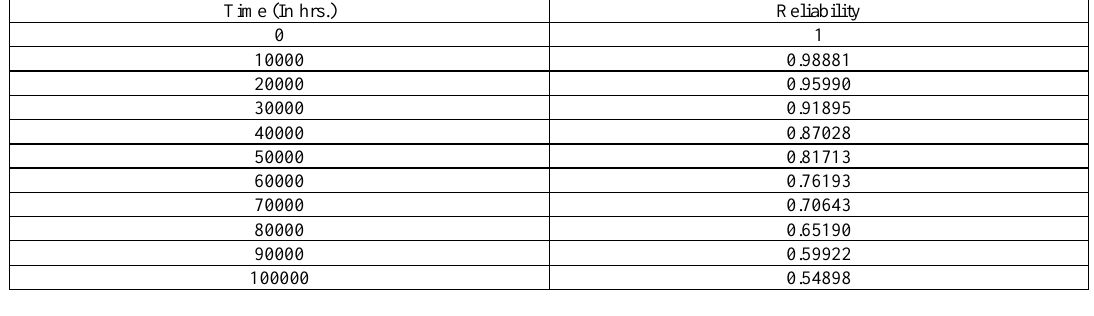
Table 4. Reliability of the system.